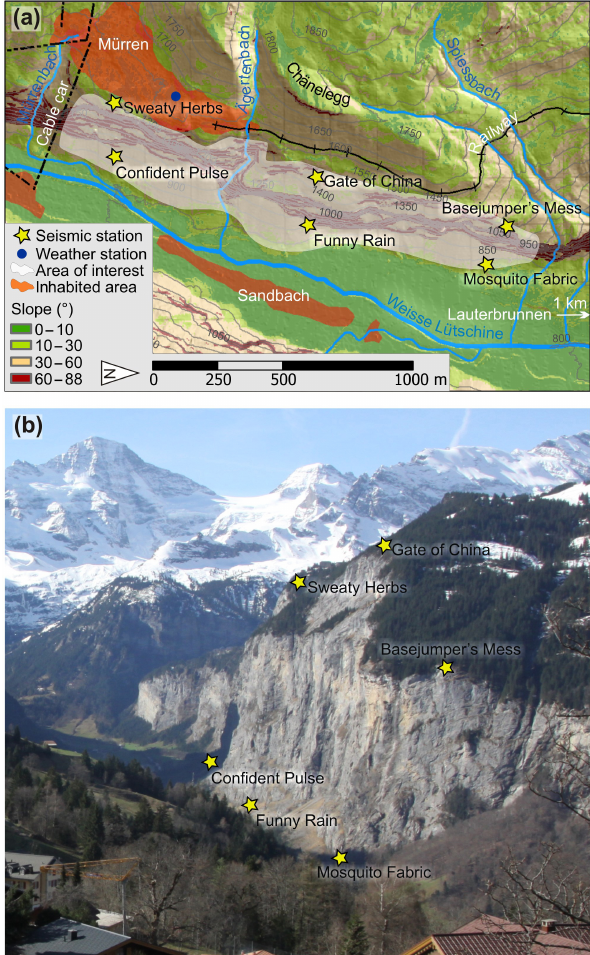
Figure 1. The study area in the Lauterbrunnen